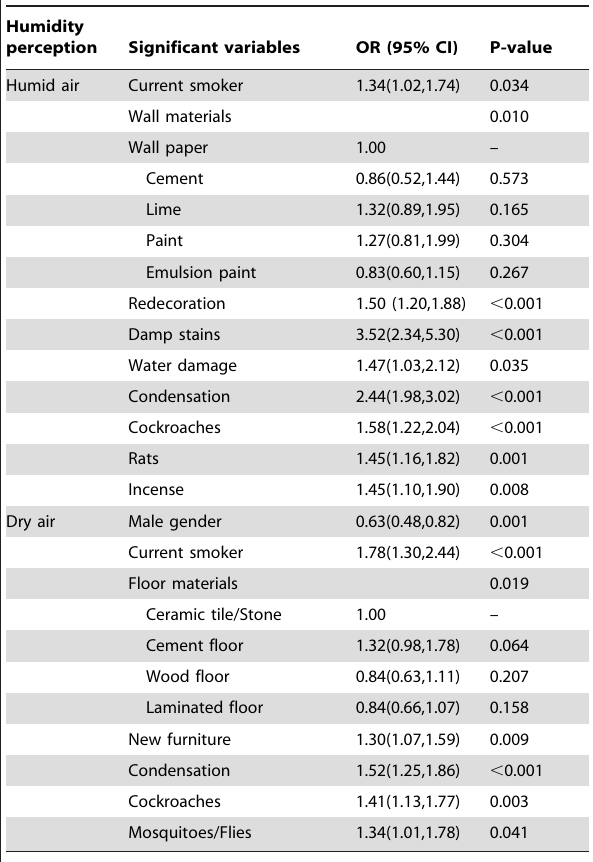
Table 9. Significant variables associated with humidity perception (weekly or sometimes), obtained by forward stepwise logistic regression